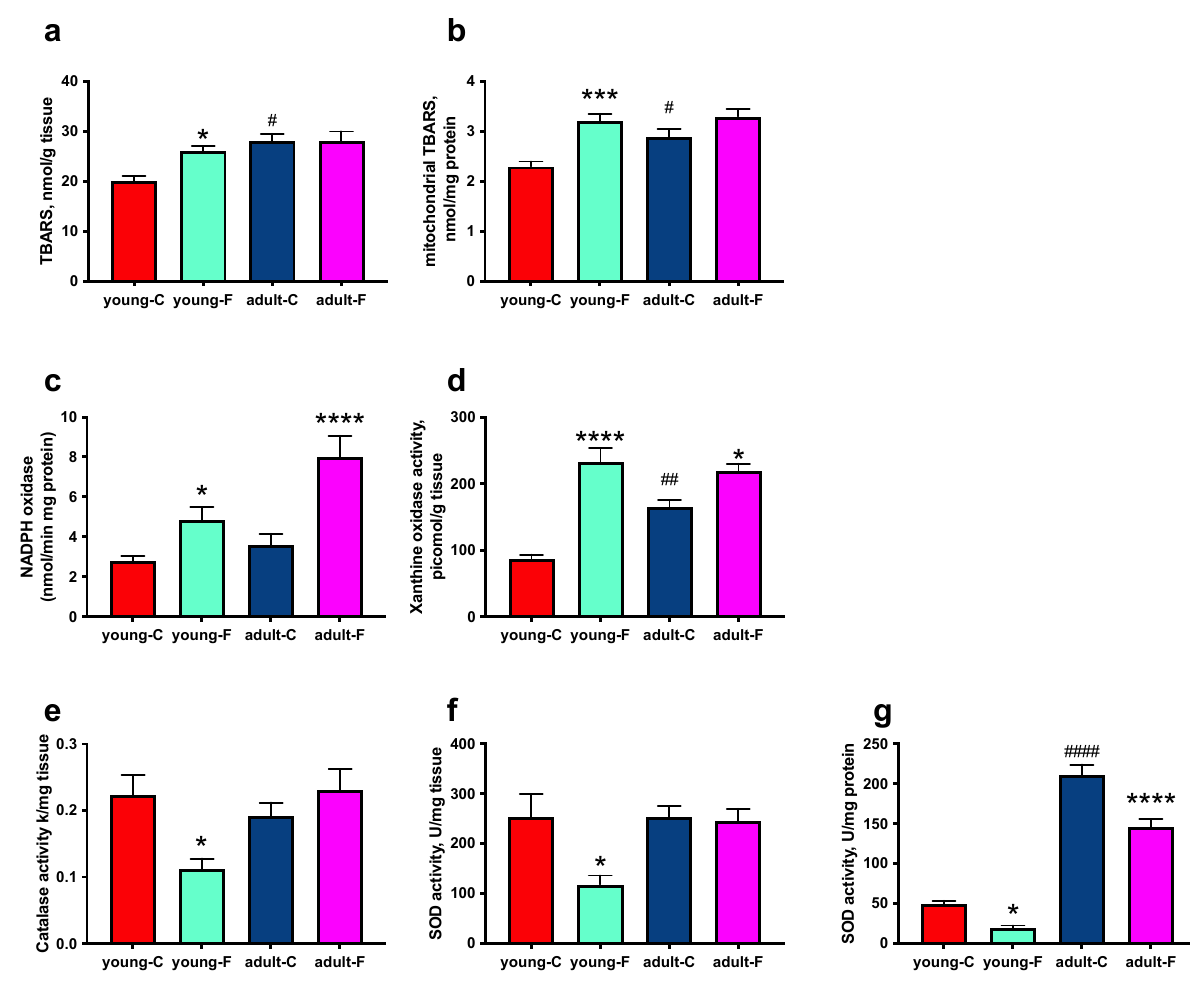
Figure 3. Markers of oxidative status. ( a ) Lipid peroxidation in skeletal muscle homogenates and